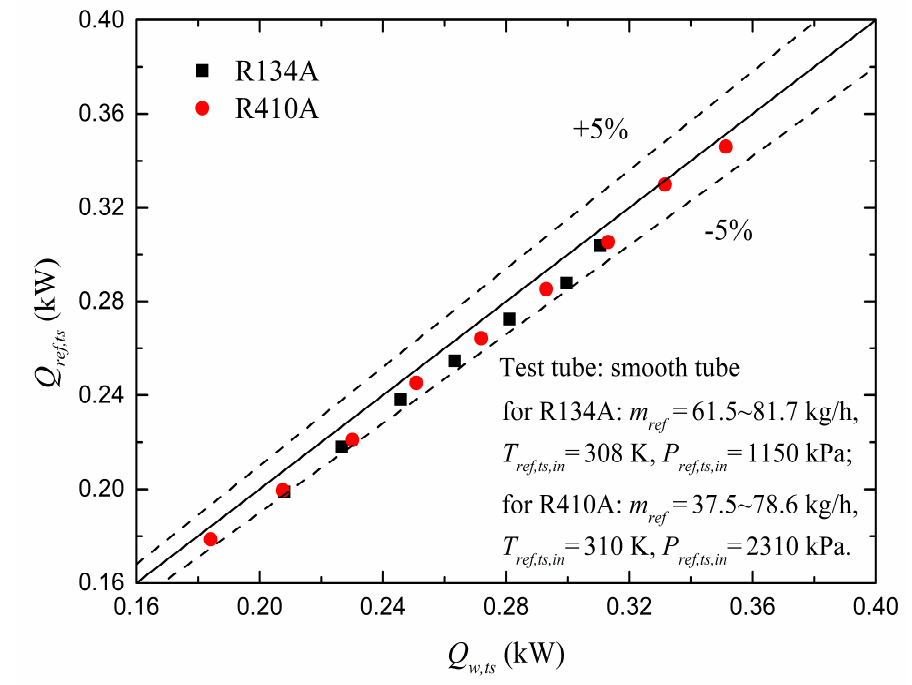
Figure 3. Heat balance measurements for single-phase flow in the smooth tube.